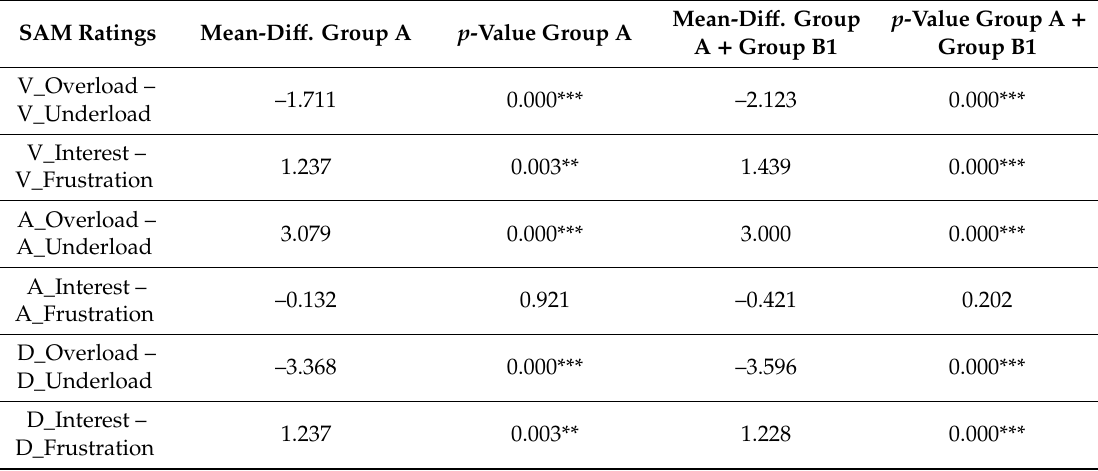
Table 4. Post-hoc Newman-Keuls corrections for the Valence (V), Arousal (A), and Dominance (D) ratings between Overload vs. Underload and between Interest vs. Frustration . Mean-Di ff erences (Mean-Di ff .) and p -values are